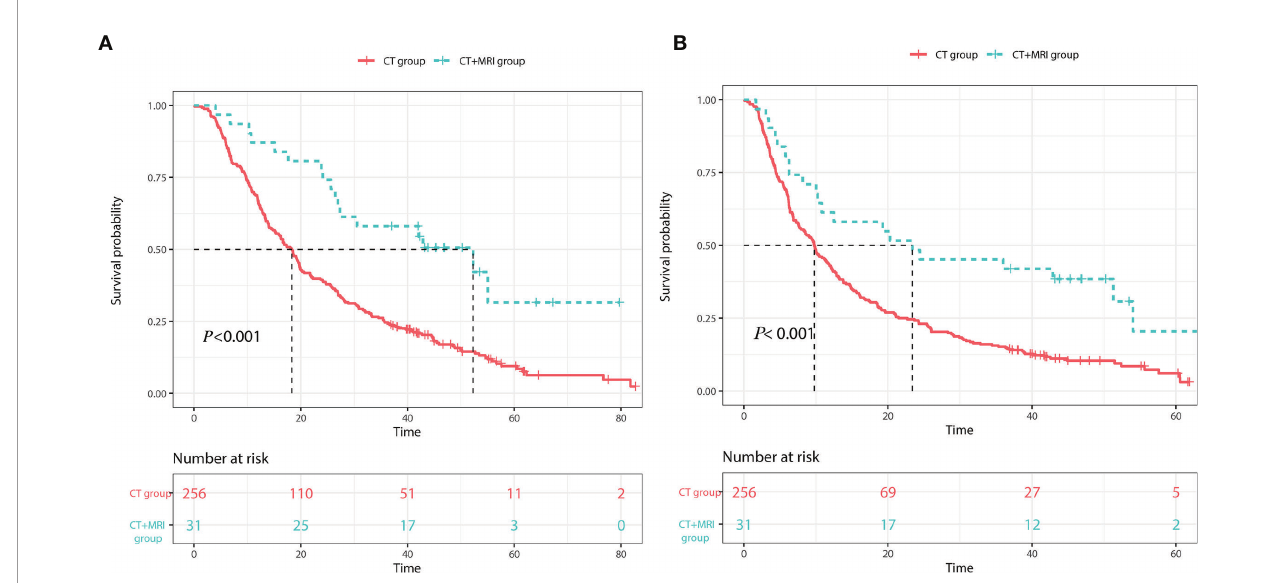
FIGURE 2 | Kaplan – Meier curves of (A) overall survival and (B) recurrence-free rates of the CT group and CT+MRI